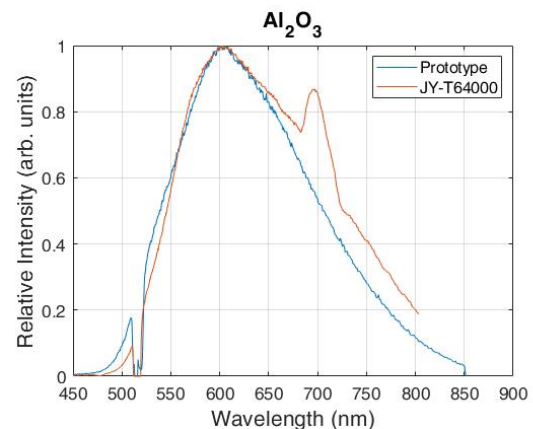
Figure 6. PL spectra of Al 2 O 3 recorded with the proposed Raman spectrometer and the reference